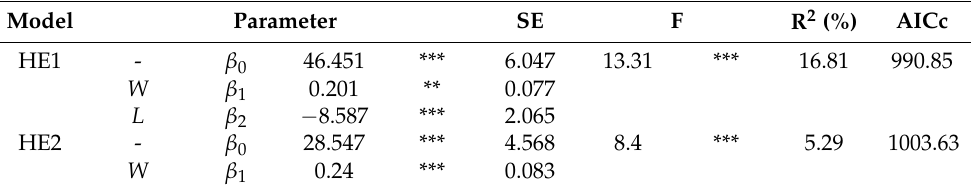
Table 4. Parameter estimates and goodness of fit statistics of the general mixed-effect models for estimating heterotrophic emissions for all land uses ( n =